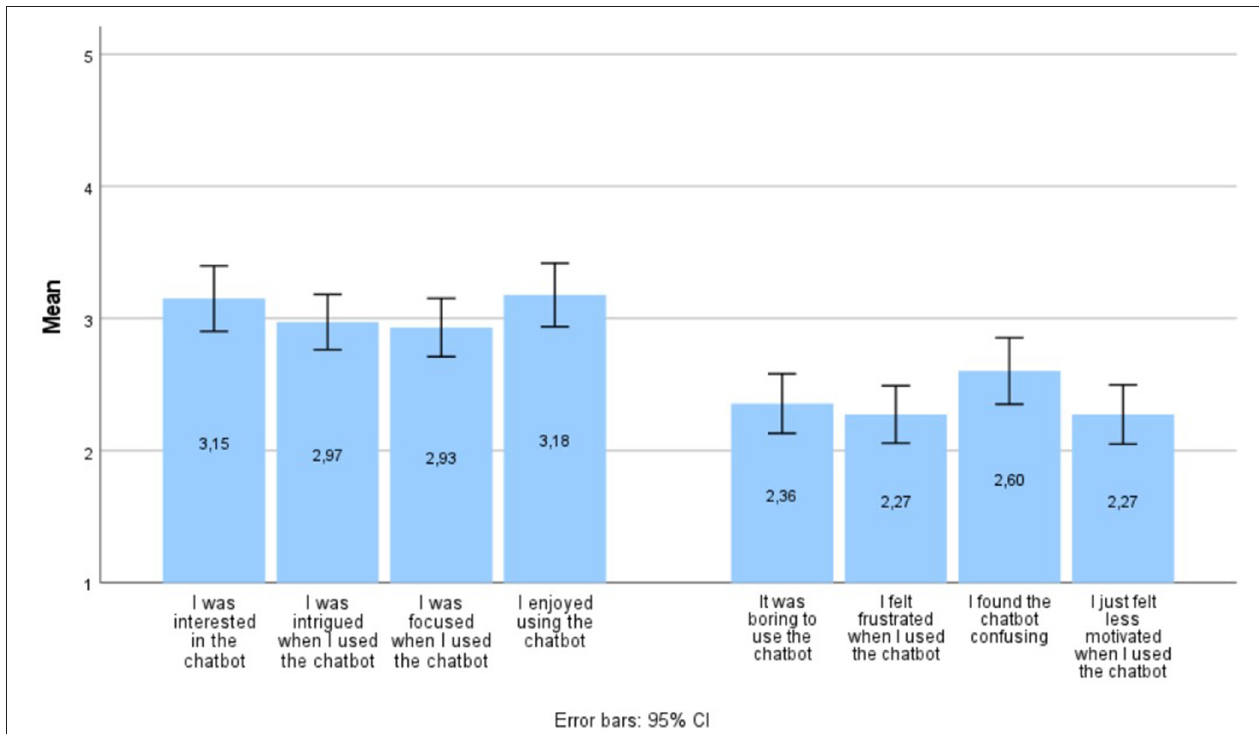
FIGURE 2 | Results (means) on the engagement items during pilot testing.